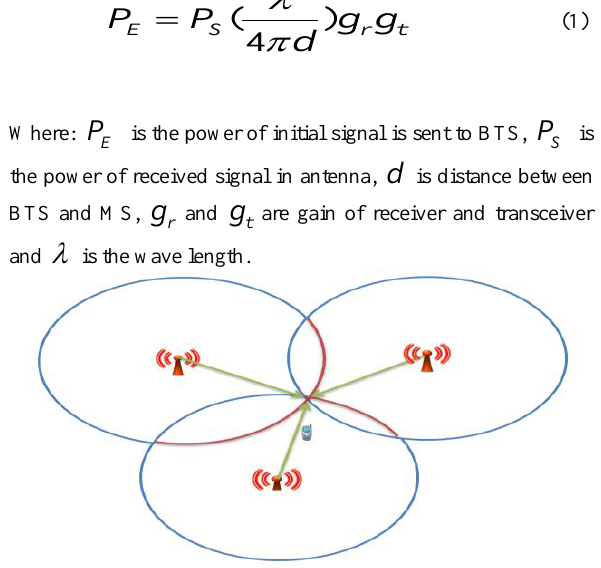
Figure 3. Signal Strength Positioning